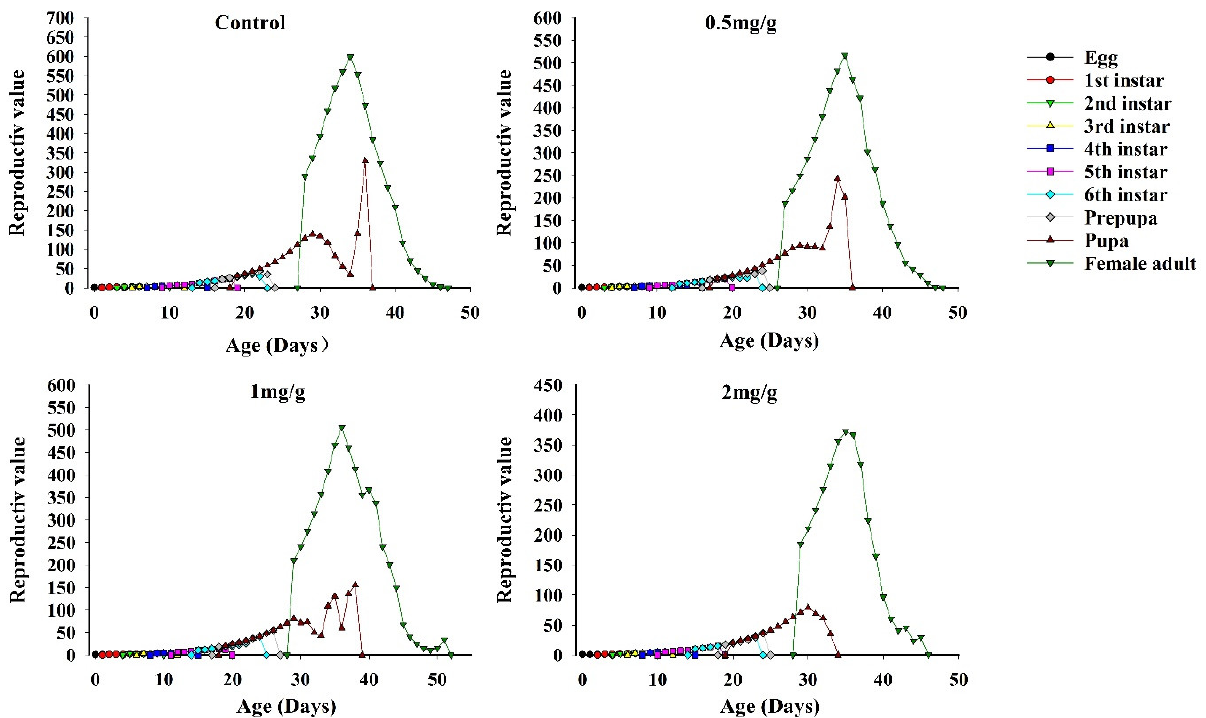
Figure 6. Age-stage characteristic reproductive values v xj of Spodoptera frugiperda at different GO concentrations.